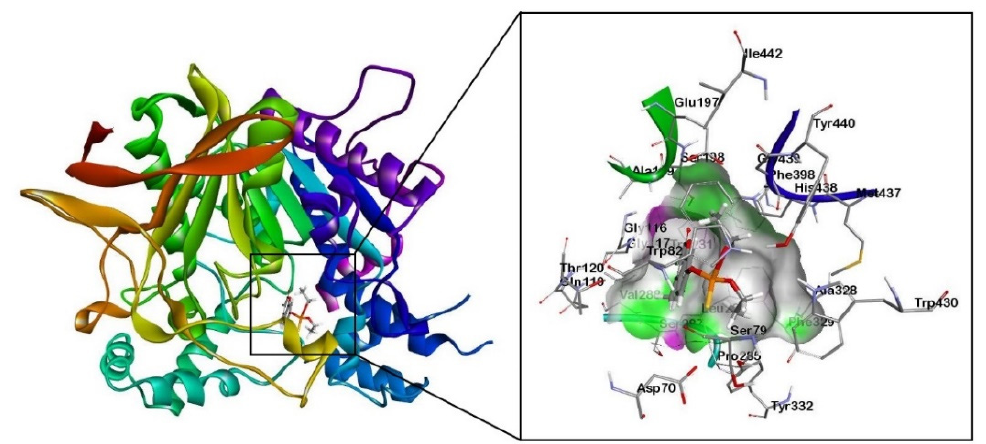
Figure 2. Molecular docking results of human BChE enzyme (PDB: 1P0M ) with organophosphorus pesticide coumaphos ( Cou ).